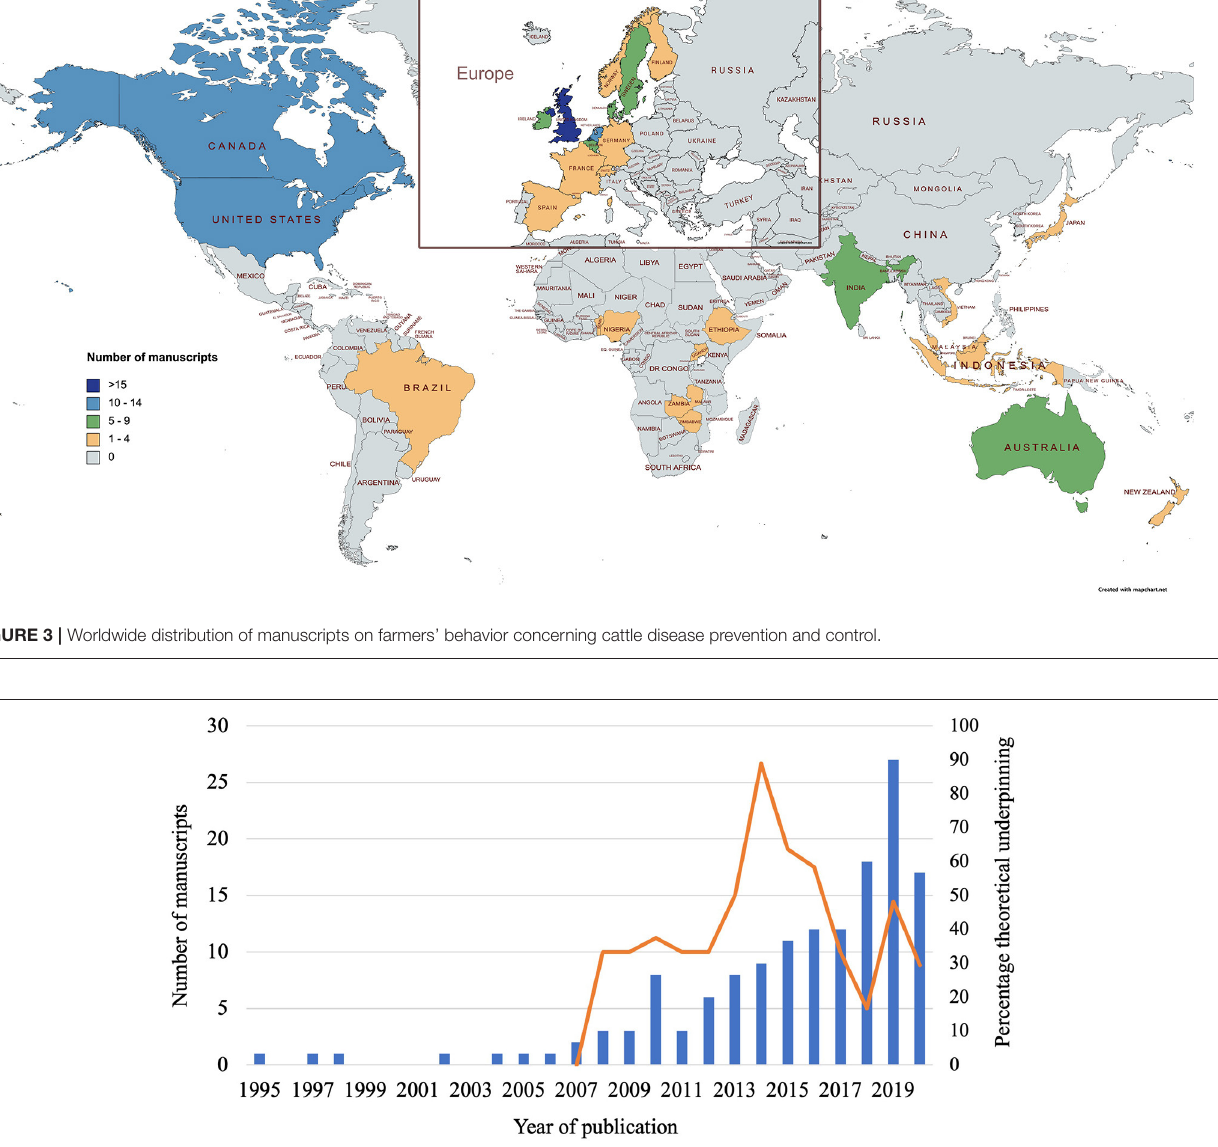
to determine farmers’ perceptions, beliefs, and attitudes were often measured with 5 or 6-point Likert scales. For